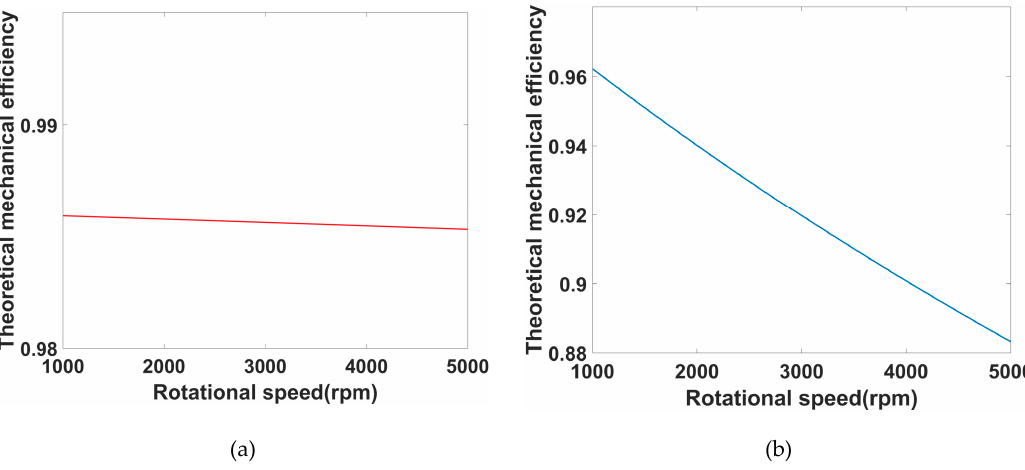
Figure 13. Theoretical mechanical e ffi ciencies at di ff erent rotational speeds. ( a ) Without considering the viscosity damping and oil stirring losses; ( b ) with considering the viscosity damping and oil stirring losses.